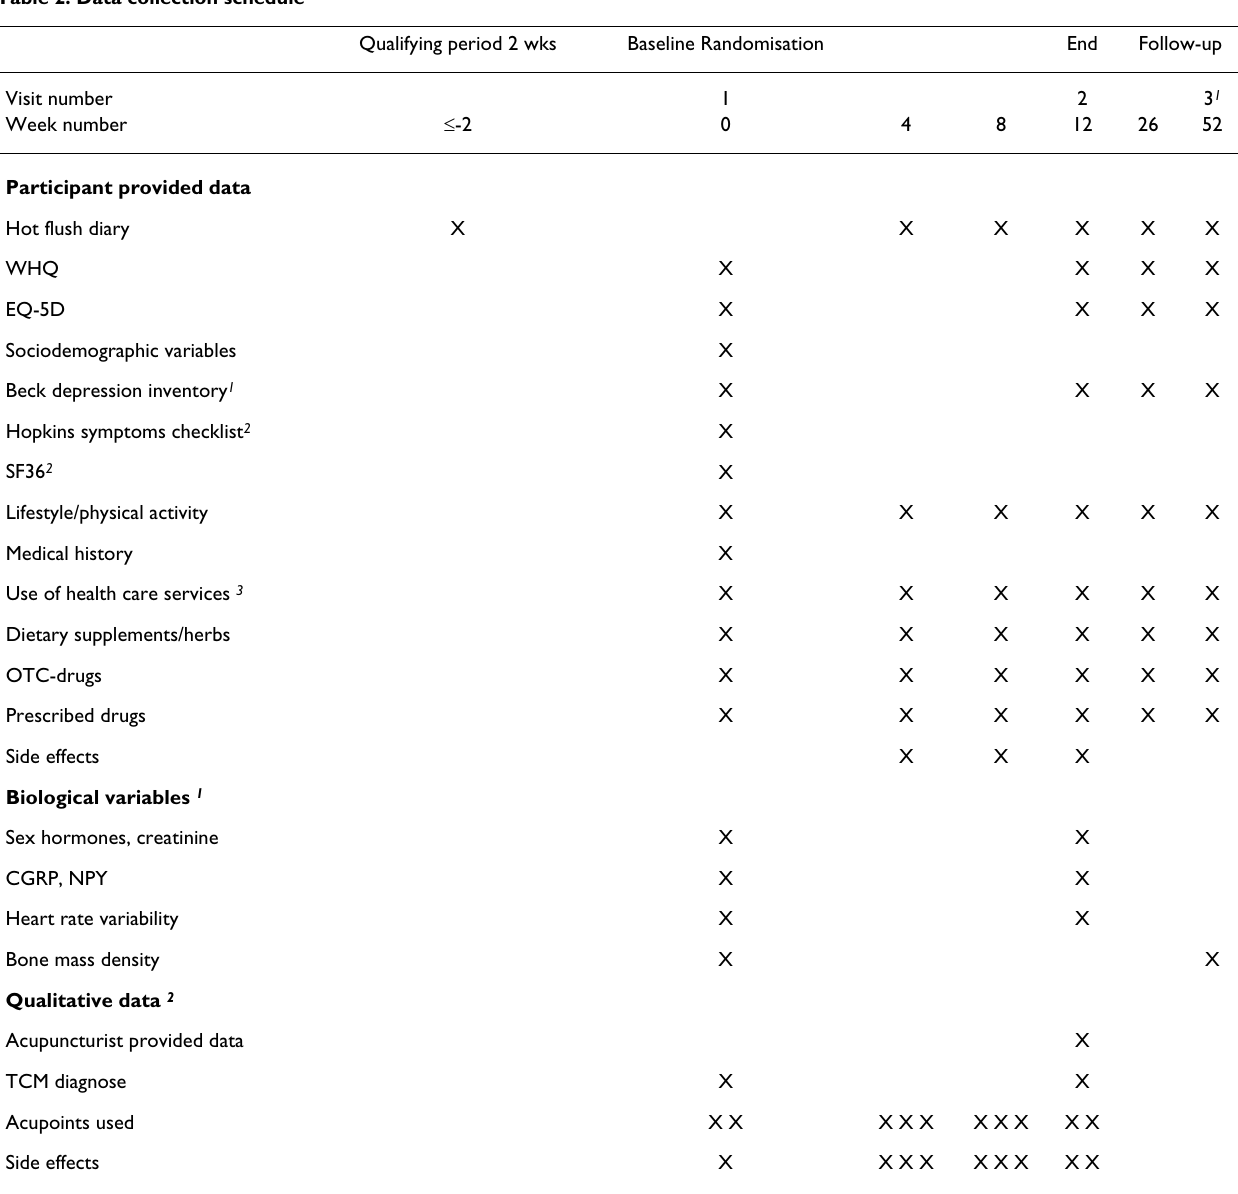
Table 2: Data collection schedule Qualifying period 2 wks Baseline